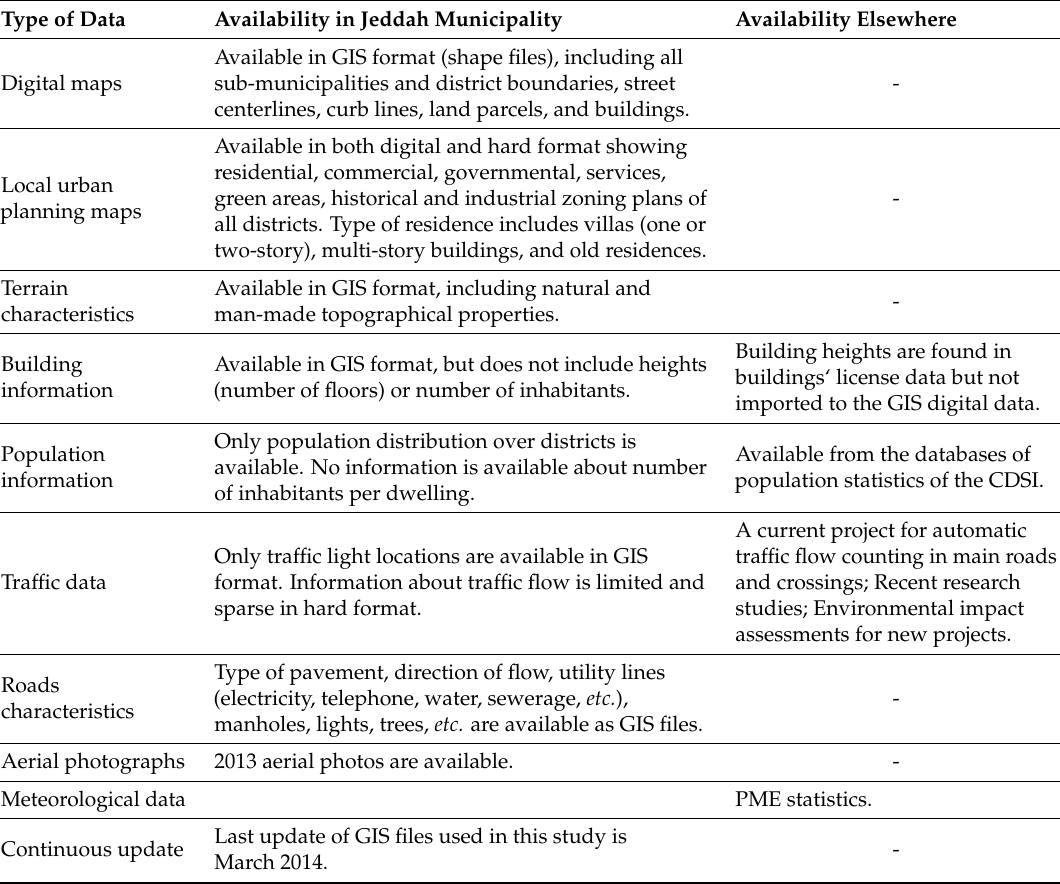
Table 2. Availability of data necessary for noise mapping at the GIS Department of Jeddah